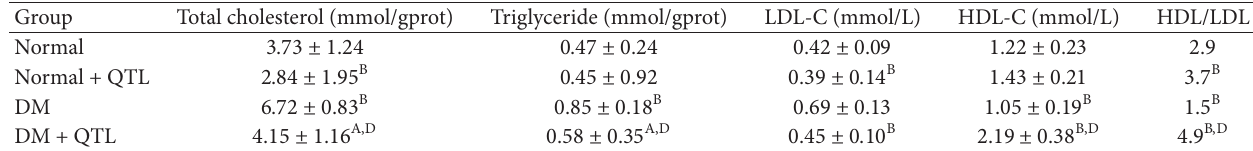
Table 1: Effect of QTL on body weight gain, glucose, and insulin levels in the normal and diabetic mice. Group Body weight gain (g) Blood glucose levels (mmol/L) Normal Normal + QTL DM + QTL 30.11 ± 3.65 D Values were expressed as mean ± SD, 𝑛 = 10 for each group. A 𝑃 < 0.05 compared to control group; B 𝑃 < 0.01 compared to control group; C 𝑃 < 0.05 compared to diabetic group; D 𝑃 < 0.01 compared to diabetic group. Table 2: Effect of QTL on lipid metabolic parameters in the normal and diabetic mice . Group Total cholesterol (mmol/gprot) Triglyceride (mmol/gprot) Normal Normal + QTL DM DM + QTL Values were expressed as mean ± SD, 𝑛 = 7 for each group. A 𝑃 < 0.05 compared to control group. B 𝑃 < 0.01 compared to control group. C 𝑃 < 0.05 compared to diabetic group. D 𝑃 < 0.01 compared to diabetic